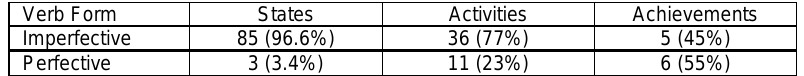
Table 6: Distribution of perfective and imperfective forms in Luis’ speech (p < 0.001, Chi-square = 27.15 [df = 2]) Verb Form States Activities Achievements Imperfective 85 (96.6%)